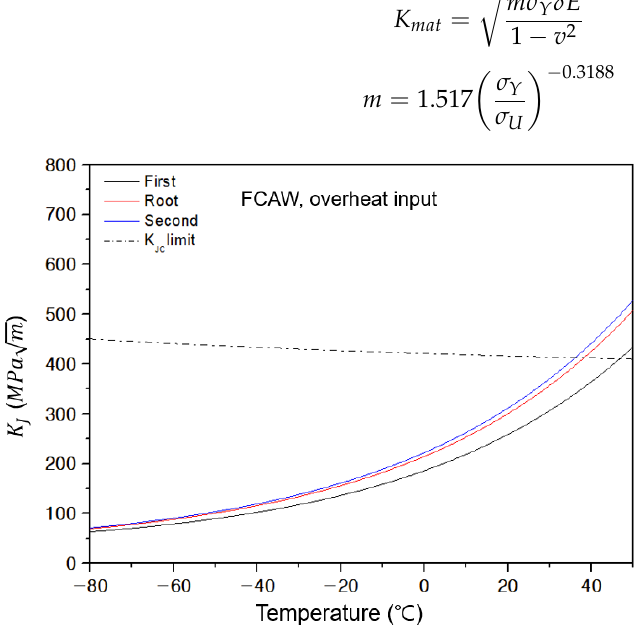
Figure 10. Master curve for FCAW, overheat input condition according to sample location.